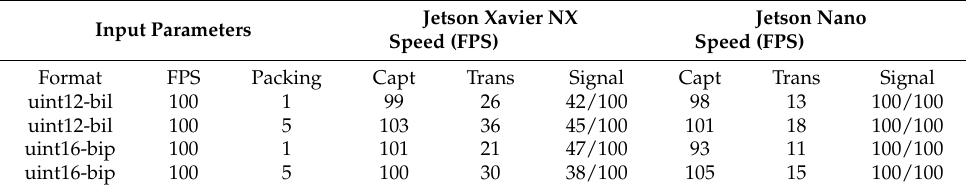
Table 4. Transmission speed without compressing the